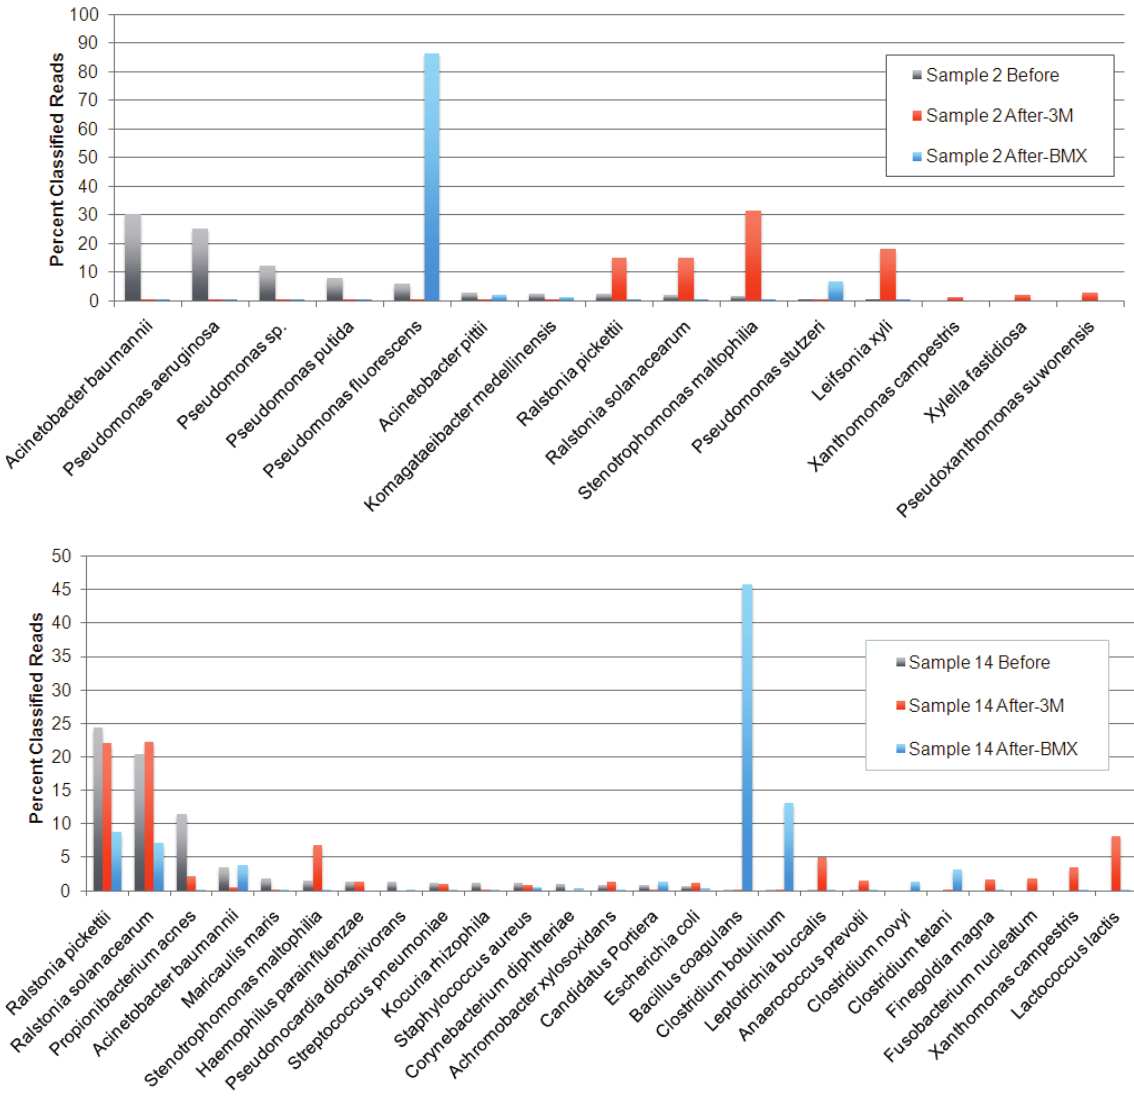
Figure 1. Genomic profiles of before and after culturing. Comparison of classified read percentages for bacterial 16S DNA on samples 2 and 14, before and after culturing on 3M and BMX media. The results represent all species observed down to 1% of classified reads. Large shifts in species prevalence are seen after growth on the two culture-based